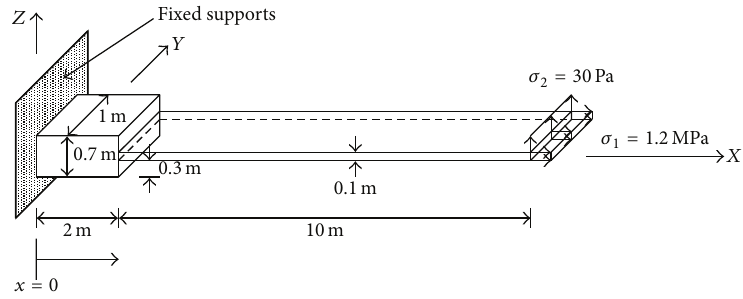
Figure 4: Cantilever plate problem ( 𝐸 = 30 MPa, Poisson’s ratio = 0).